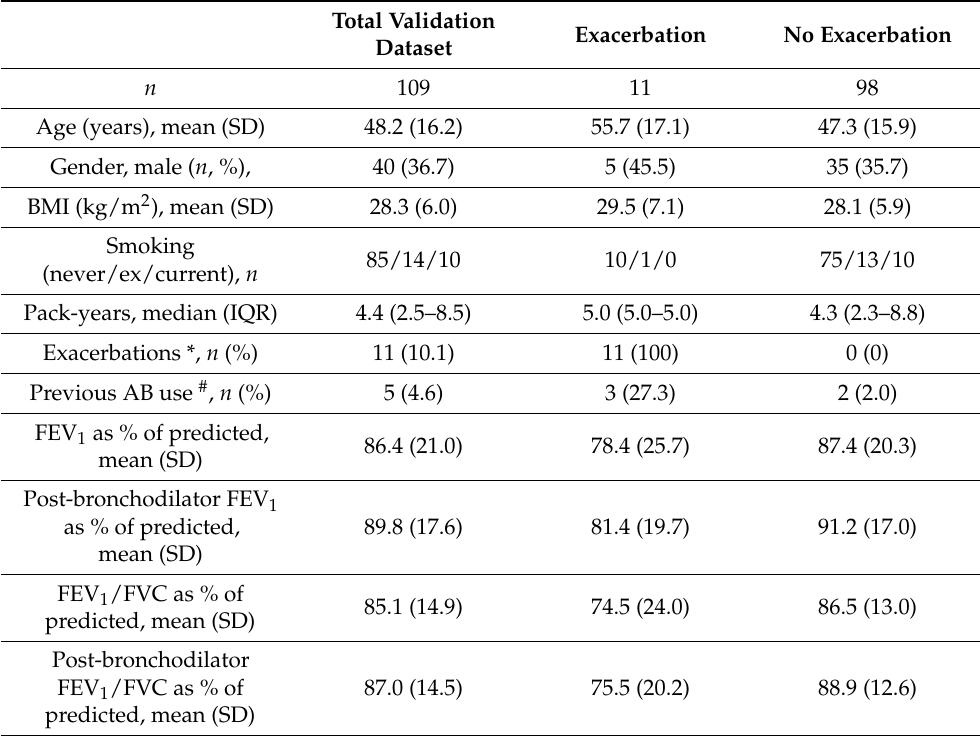
Table 2. Baseline characteristics of the validation